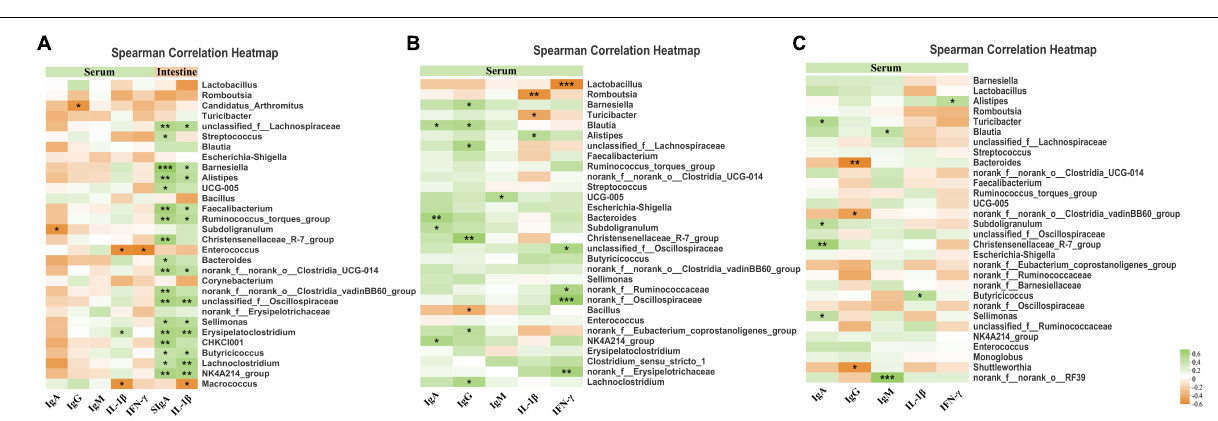
globulins (IgA and IgM), while the abundance of Shuttleworthia , norank_f__Clostridiales_vadinBB60_group , and Bacteroides were negatively associated with the levels of IgG. Lower levels of IL-1 β and IFN- γ displayed a negative association with the abundance of Butyricicoccus and Alistipes